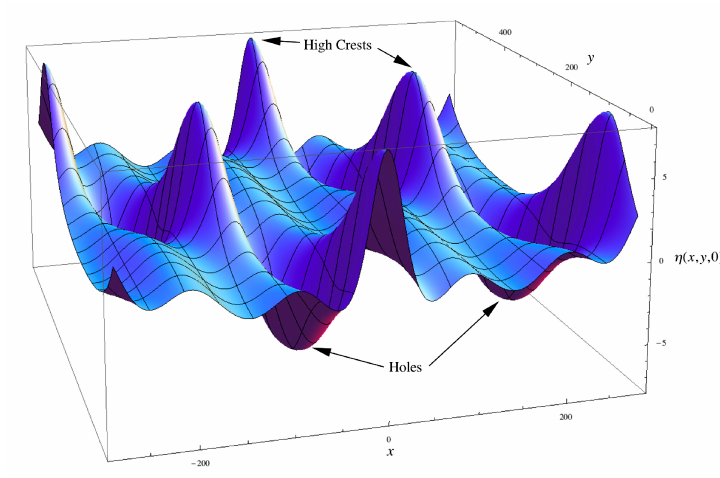
Figure 13. Oblique breather train moving at 30 ◦ relative to the dominant wave direction. This is a breather wave train formed by two phase-locked Stokes waves (Equations (78)–(84) below with rotation). It is the analogue of a breather in 1 + 1 dimensions and has a 2 × 2 Riemann spectrum from which this graph was made. This solution is a single nonlinear Fourier component in the finite gap theory for the unstable modes in the cyan region of Figure 4.